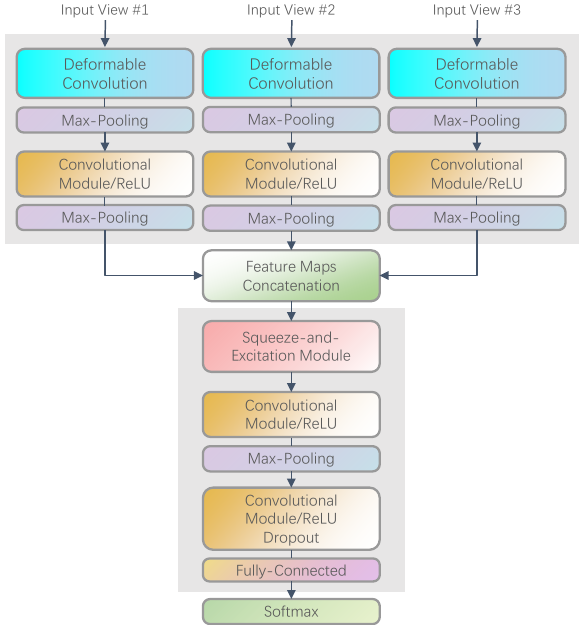
Figure 2. The basic architecture of FEF-Net for multiview SAR